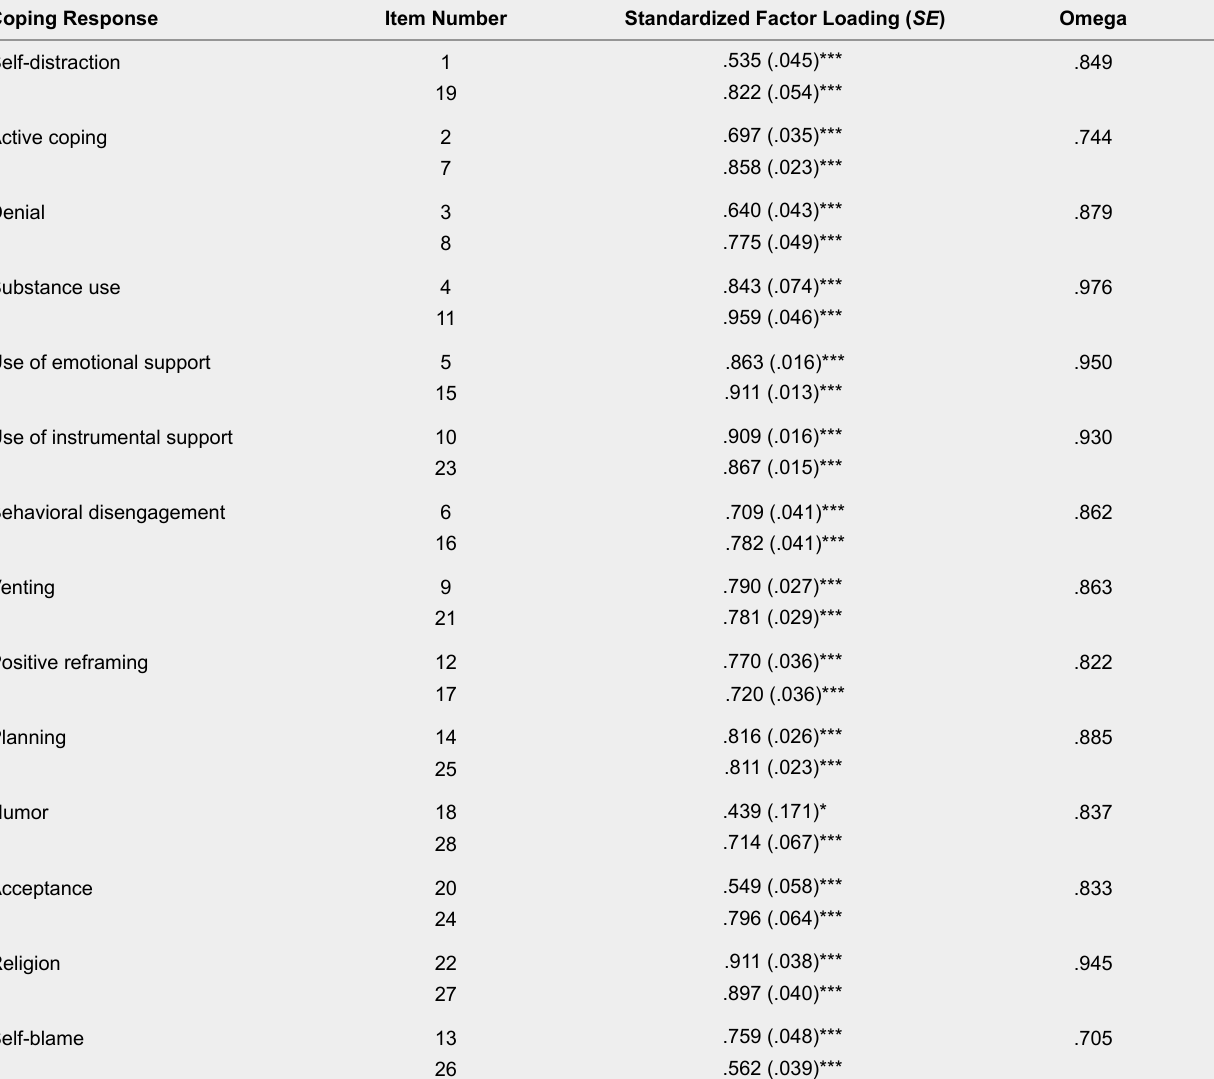
Standardized Factor Loadings and Omega Coefficient for the 14 Coping Response